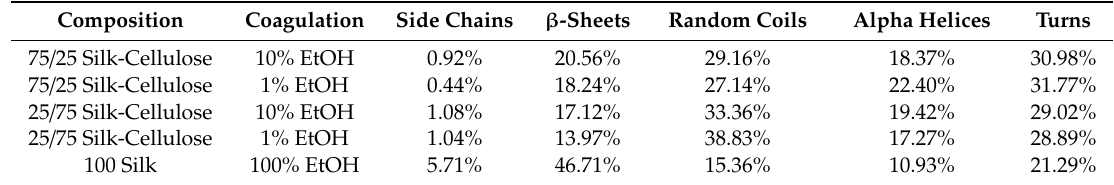
Figure 1. Fourier transform infrared spectroscopy (FTIR) spectra of regenerated silk and cellulose samples, as well as silk / cellulose biocomposites with varying composition ratios and coagulation agents. Table 1. Secondary structure contents of the 100% regenerated silk sample, and 25% silk and 75% silk